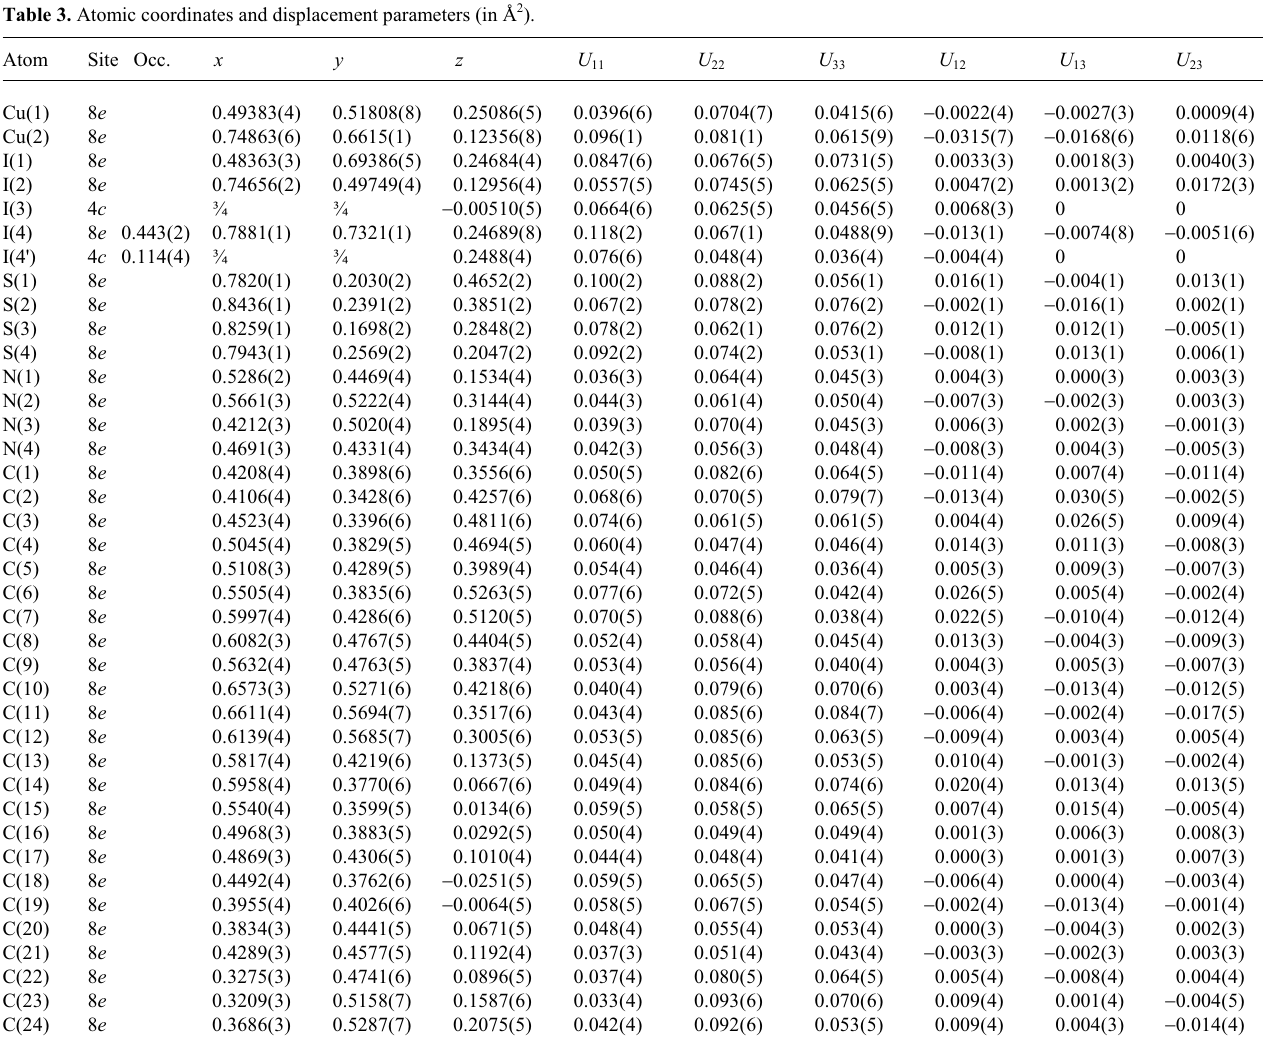
Table 3. Atomic coordinates and displacement parameters (in Å 2 ).